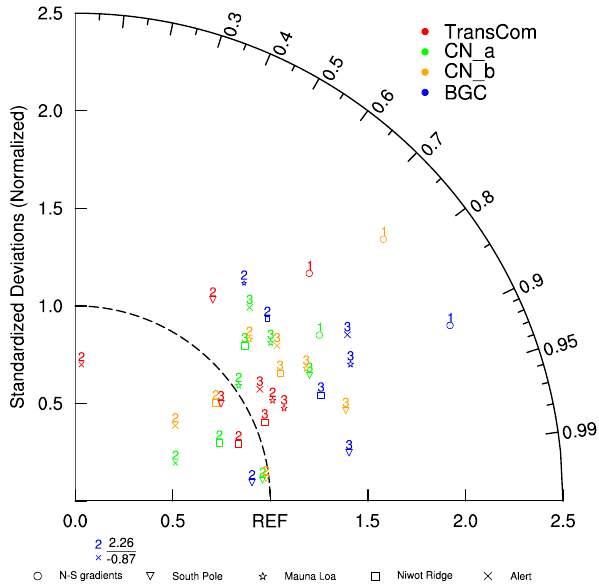
Figure 15. Taylor diagram comparing model N–S gradients (no. 1), annual growth rates (no. 2), and interannual variability (no. 3) with observations for the South Pole, Mauna Loa, Niwot Ridge, and Alert (Canada) stations, respectively for the four simulations. The four stations are selected to represent the South Pole, tropics, mid-latitudes, and high latitudes. The annual growth rate is calcu- lated as the difference between the mean methane concentrations of the current year and the previous year. The N–S gradients are from Fig.